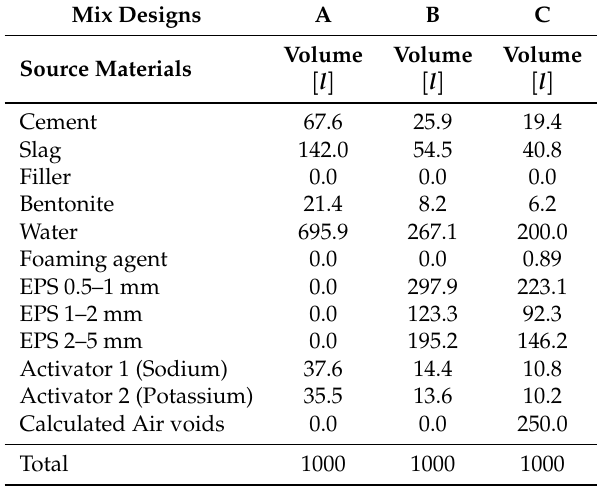
Figure 3. ( Top ): Schematic illustration of three different grout mixes prepared within the experimental program. ( Bottom ): Direct light microscope images of hardened grout samples B and C. Table 2. Mixture design for grout samples A, B, and